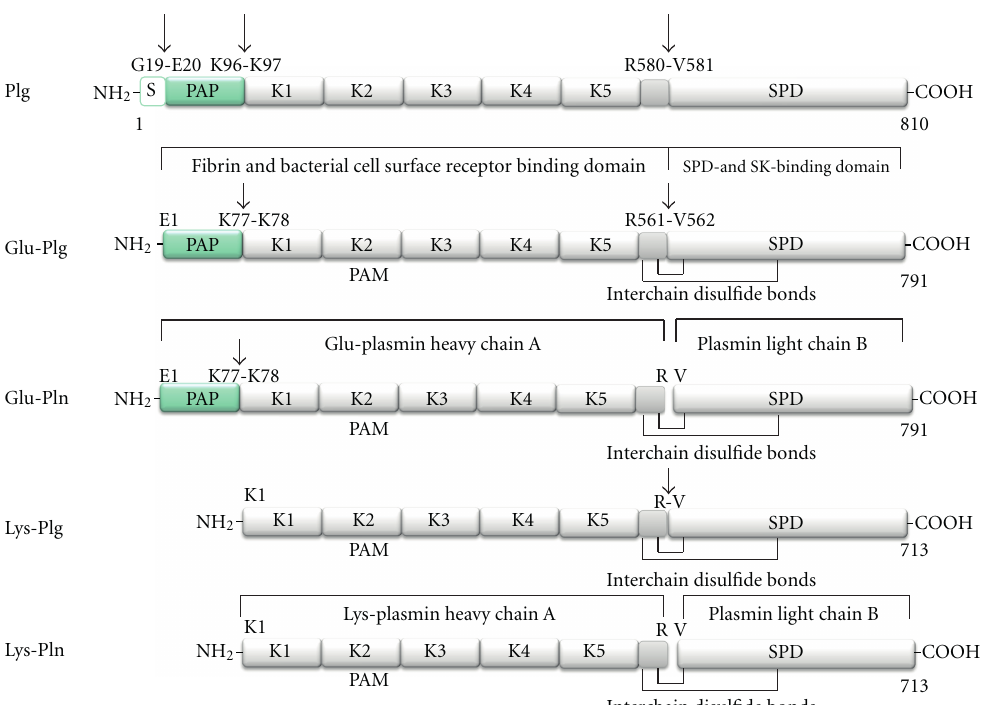
Figure 1: Structural domains of human plasmin(ogen) forms. Human plasminogen is synthesised as an 810 amino acid protein. The 19 amino acid residue signal sequence is removed resulting in the circulating mature form (791 amino acids, ∼ 90,000 kDa) known as Glu-plasminogen (Glu-plg) as it contains an N-terminal glutamic acid. Glu-plg contains a hairpin-loop structure called the PAN domain encompassing the preactivation peptide (PAP), followed by 5 homologous kringle domains (K1–K5) containing three intradomain disulfide bridges, followed by a peptidase S1 domain (SPD). The preactivation peptide is generated by plasmin cleavage giving rise to Lys-plg (713 amino acids, ∼ 80,000 kDa). The conversion of Glu-plg or Lys-plg to their respective plasmin forms occurs by hydrolysis of the Arg-Val peptide bond shown by either uPA or tPA, yielding chain A and the smaller chain B, which remain covalently associated by interchain disulfide bonds. Kringles 1, 2, 4, and 5 contain lysine-binding sites (LBS) with a ffi nity for free lysine and lysine-like compounds such as ω -aminocarboxylic ligands in the following order of binding a ffi nity K1 > K4 > K5 > K2 [8]. Kringle 3 shows no detectable binding to Lys or Lys-like compounds [9], related to a sequence variation in its LBS. Glu-plg thus binds to various lysine-containing proteins via Kringles 1, 2, 4, and 5. Streptokinase (SK) and staphylokinase (not shown) bind in a 1: 1 complex with the SPD to generate an activator complex. Not shown: Mini plasminogen (K5 plus the SPD) can also be generated by stromelysin-19 cleavage of the Pro466-Val467 bond of Plg. Sequence data are derived from UniProt (swiss-prot entry P00747). Plasminogen (EC = 3.4.21.7)